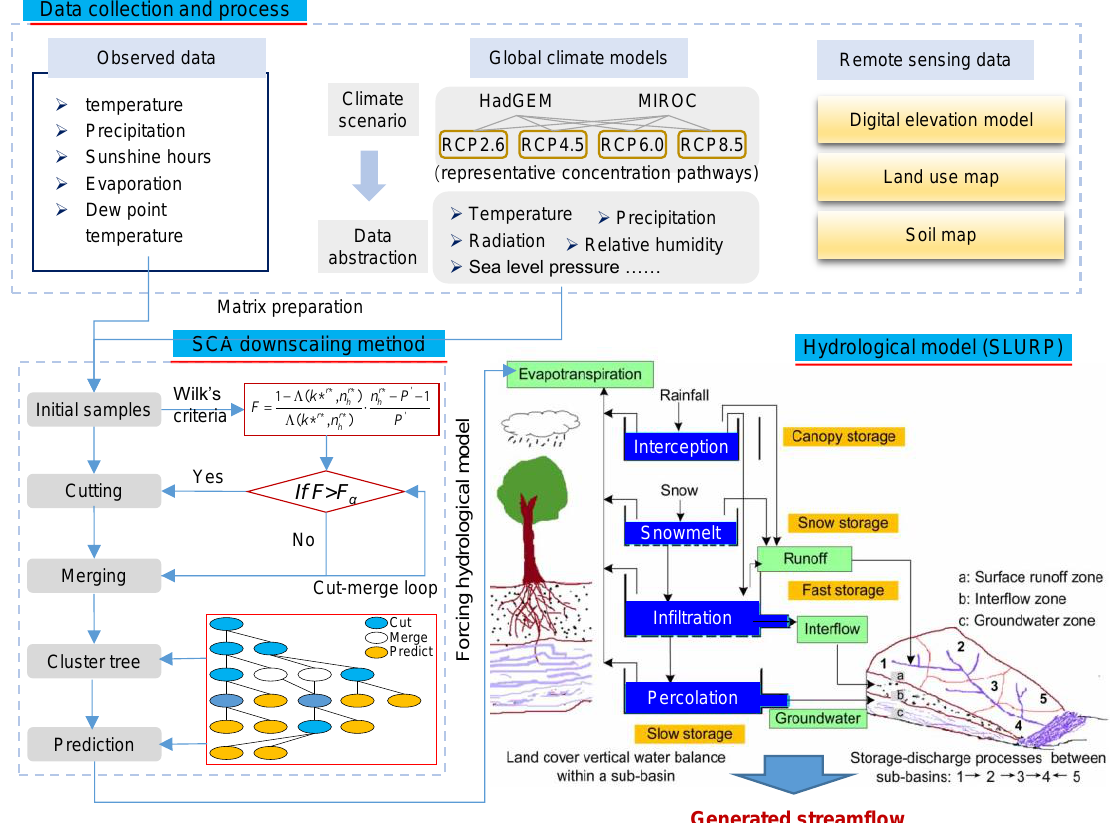
Figure 1. The framework of the ensemble climate–hydrology modeling system (the flowchart of semi-distributed land use-based runoff process (SLURP) is derived from Sun et al. [24]).